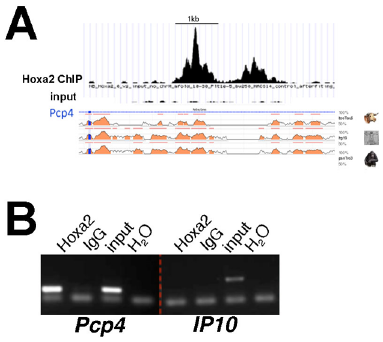
Figure 3. Hoxa2 binds Pcp4invivo . A, High enrichment of the first intron of the Pcp4 gene compared to input (mm9, chr16:96,717,332- 96,718,404) in Hoxa2 ChIP-seq. Evolutionary Conserved Regions (ECRs) plot generated by the ECR Browser, comparing the genomic region bound by Hoxa2 between human, chimpanzee, and cow [29]. B, Conventional ChIP on IIBA chromatin confirms enrichment of Hoxa2 to Pcp4 . IP10 is a negative control gene. IgG is a non-specific negative control antibody.